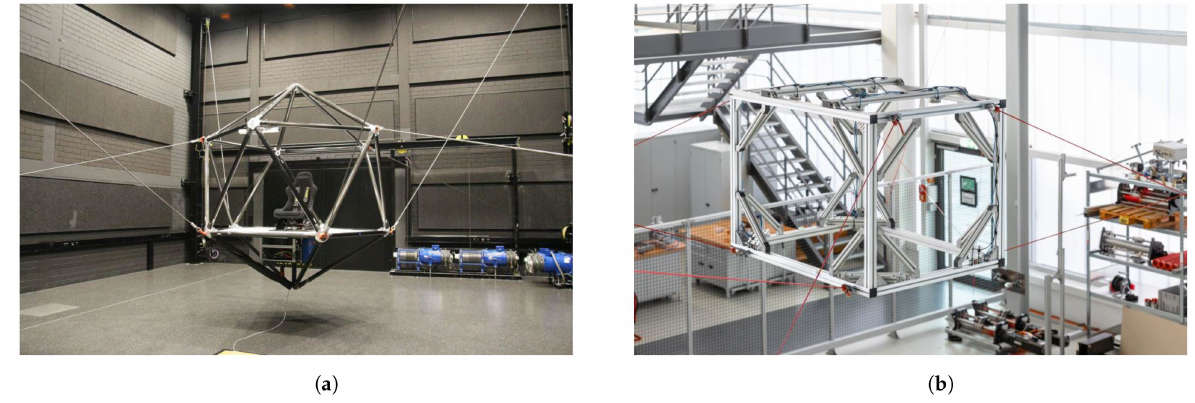
Figure 4. Two CDPR setups. ( a ) The CableRobot Simulator [34]. Reproduced with permission from Max Planck Institute for Biological Cybernetics ©2015. ( b ) The IPAnema 3 CDPR [35]. Reproduced with permission from Fraunhofer IPA ©